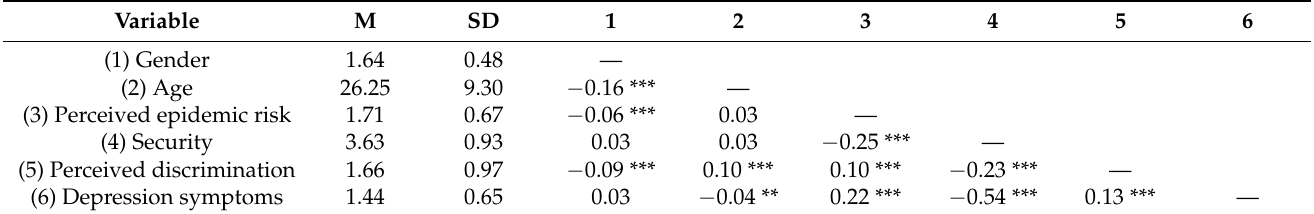
Table 1. Means, standard deviations, and intercorrelations of variables ( N = 3443).